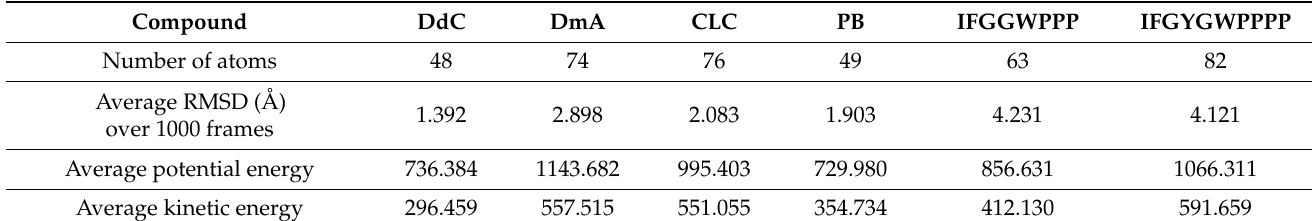
Table 4. Average RMSD and energy (KJ) obtained from molecular dynamics simulations.